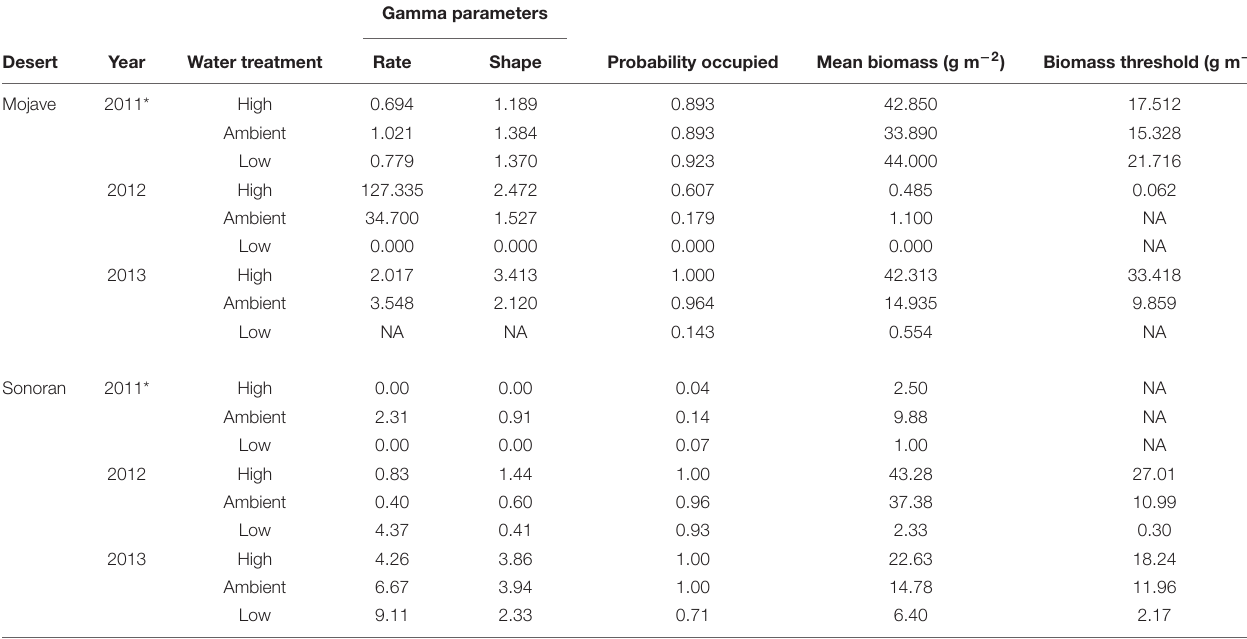
TABLE 2 | Biomass values for matrix microhabitat (OF) fit to a gamma distribution from the experiments conducted in the Mojave and Sonoran deserts. Gamma